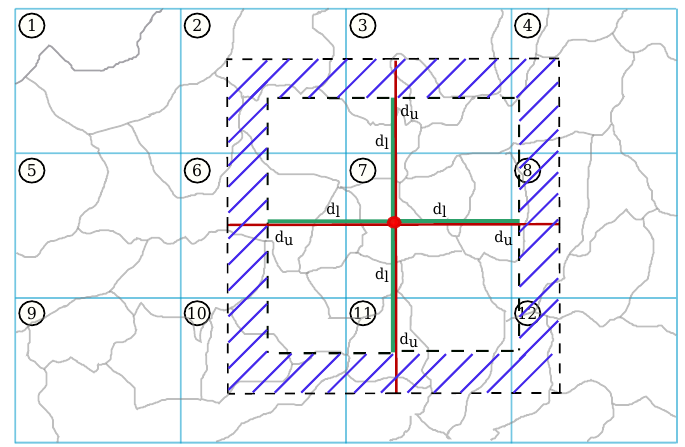
Figure 7. Retrieving segments relevant to the distance criteria given in the query. Segments are shown in blue rectangles. The red point indicates the point p c selected by the user on the map. The boundaries (lower and upper bounds) are also shown in green (d l ) and red (d u )